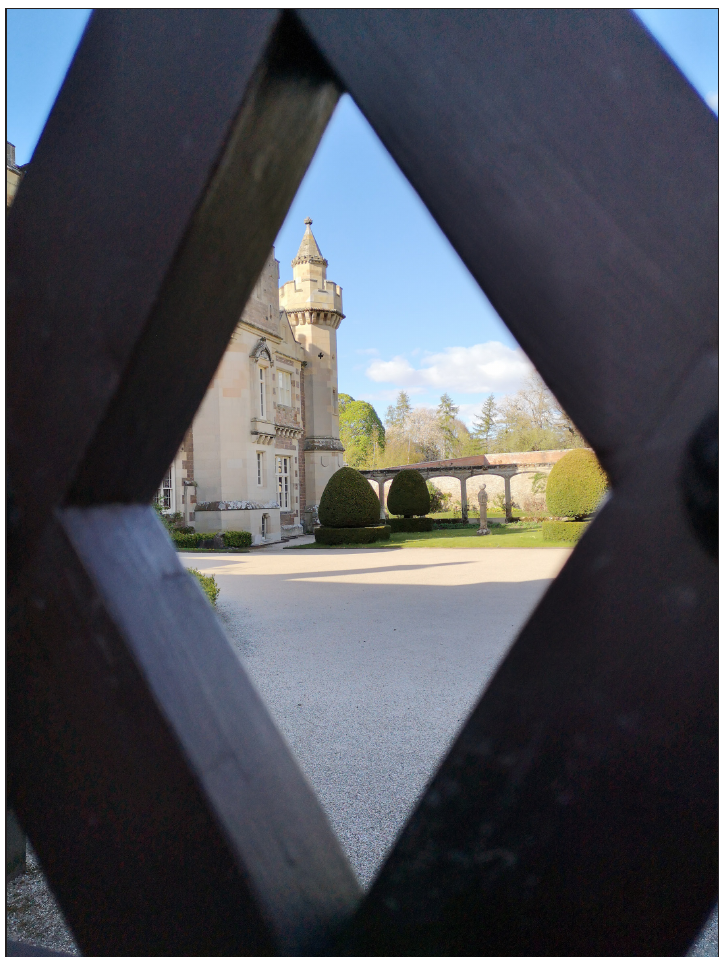
Fig. 1 : A view of Abbotsford through Scott’s Portcullis Gates. Photo: Abbotsford